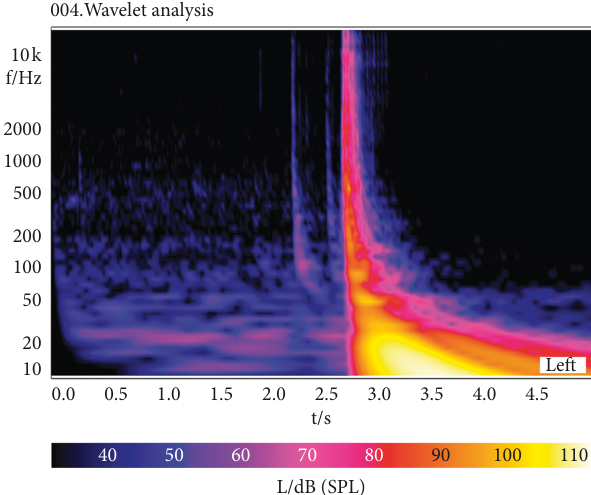
Figure 4: Continuous wavelet transform of sample S